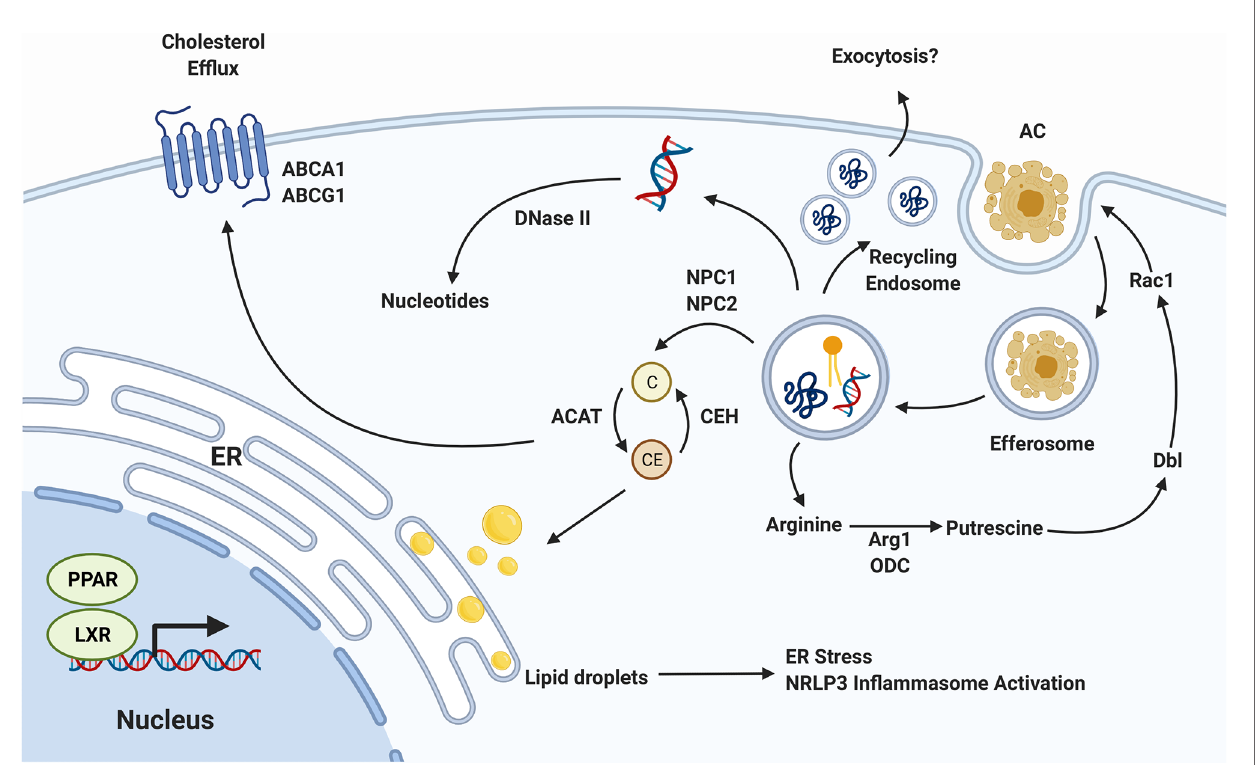
FIGURE 2 | Efferocyte Metabolism. The biomolecules released as efferocytosed apoptotic cells are degraded must be processed by the efferocyte, incurring a signi fi cant metabolic load. Cholesterol (C) is exported from the efferosome to cytosolic carriers which, in the presence of cholesterol transporters such as pABCA1 and ABCG1, can export this cholesterol to circulating high density lipoprotein. In the absence of suf fi cient export, cholesterol is esteri fi ed into cholesterol esters (CE) which can accumulate in the endoplasmic reticulum (ER). DNA is degraded in the efferosome by DNase II, and proteins by a range of cathepsin and other proteases, with the resulting nucleotides and amino acids transported into the cytosol where they are recycled. The amino acid arginine is converted in the cytosol to the putrescine, which activates Dbl to enhance Rac1 activity, thereby promoting the efferocytosis of additional apoptotic cells. Lastly, the activation or PPAR and LXR nuclear receptors by lipid-derived metabolites induces a pro-efferocytic metabolic pro fi le via upregulation of cholesterol export machinery and upregulation of lipid b -oxidation. Figure prepared in